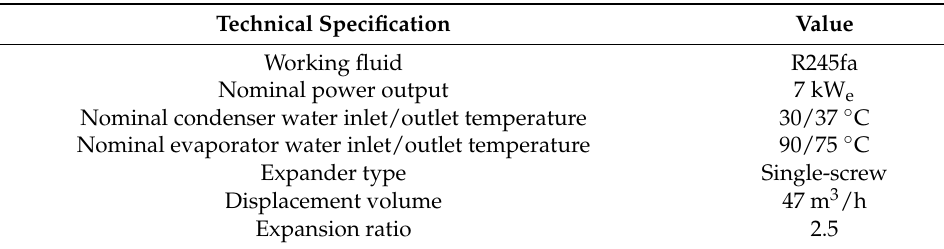
Table 3. Organic Rankine Cycle: Manufacturer’s